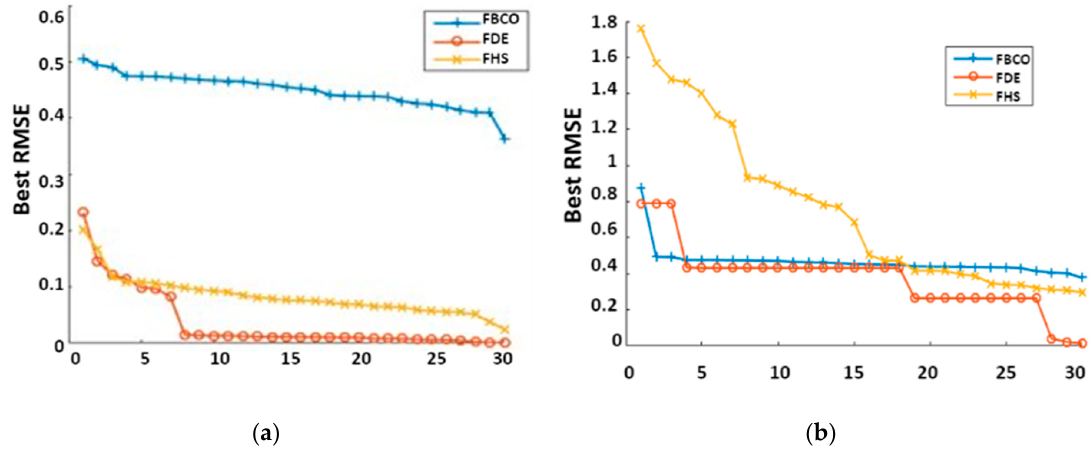
Figure 19. Comparison of the RMSE for each method for both benchmark problems with noise: ( a ) water tank controller, and ( b ) inverted pendulum on a cart controller.